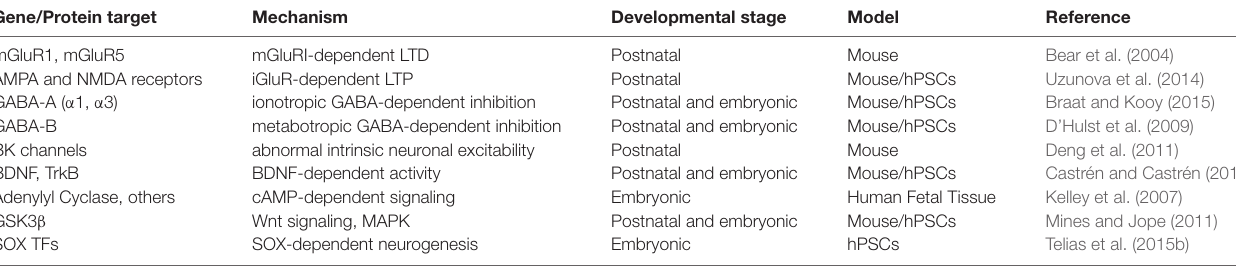
TABLE 1 | Summary of mechanisms involved in Fragile X Syndrome (FXS)